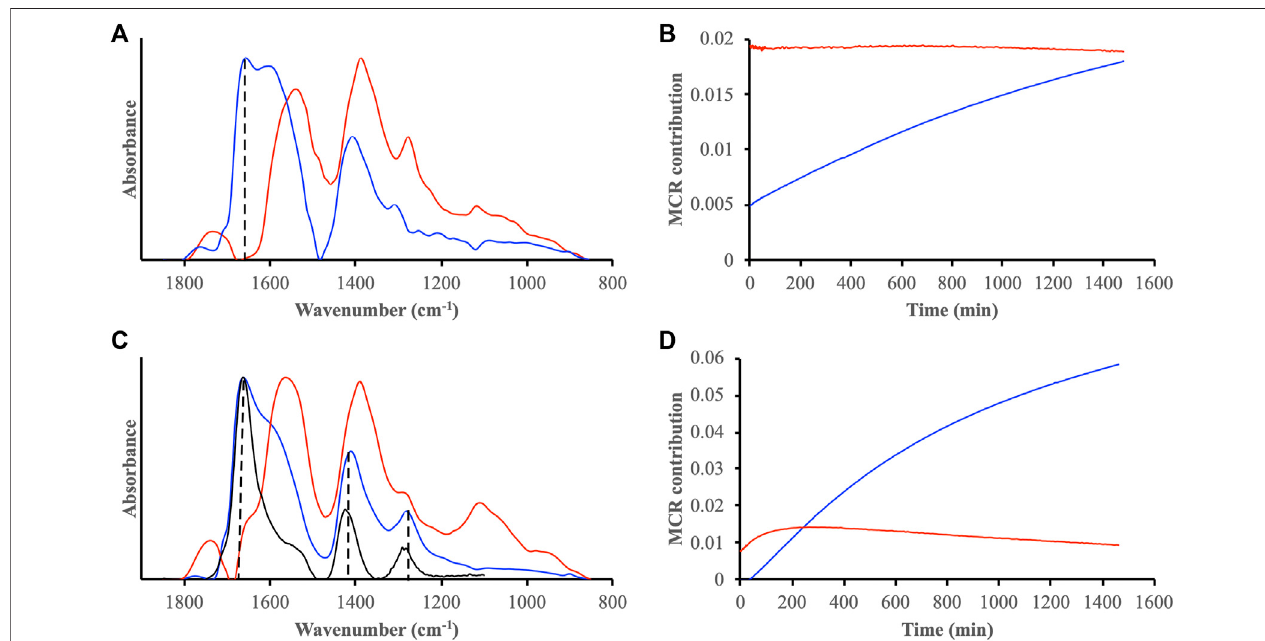
FIGURE 9 | Results from MCR-ALS analysis of IR spectral data sets collected during reactions between H 2 O 2 and DOM mod-EtOAc -ferrihydrite associations. The DOM mod-EtOAc -ferrihydrite associations were pre-equilibrated for 24 h (A,B) and 1 h (C,D) prior to addition of H 2 O 2 . The resolved MCR spectra are shown in A and C, and the corresponding MCR contributions in B and (D) . Included in C is also the spectrum of oxalate adsorbed to ferrihydrite at pH 4.0 and 1.2 μ mol m − 2 (black line).